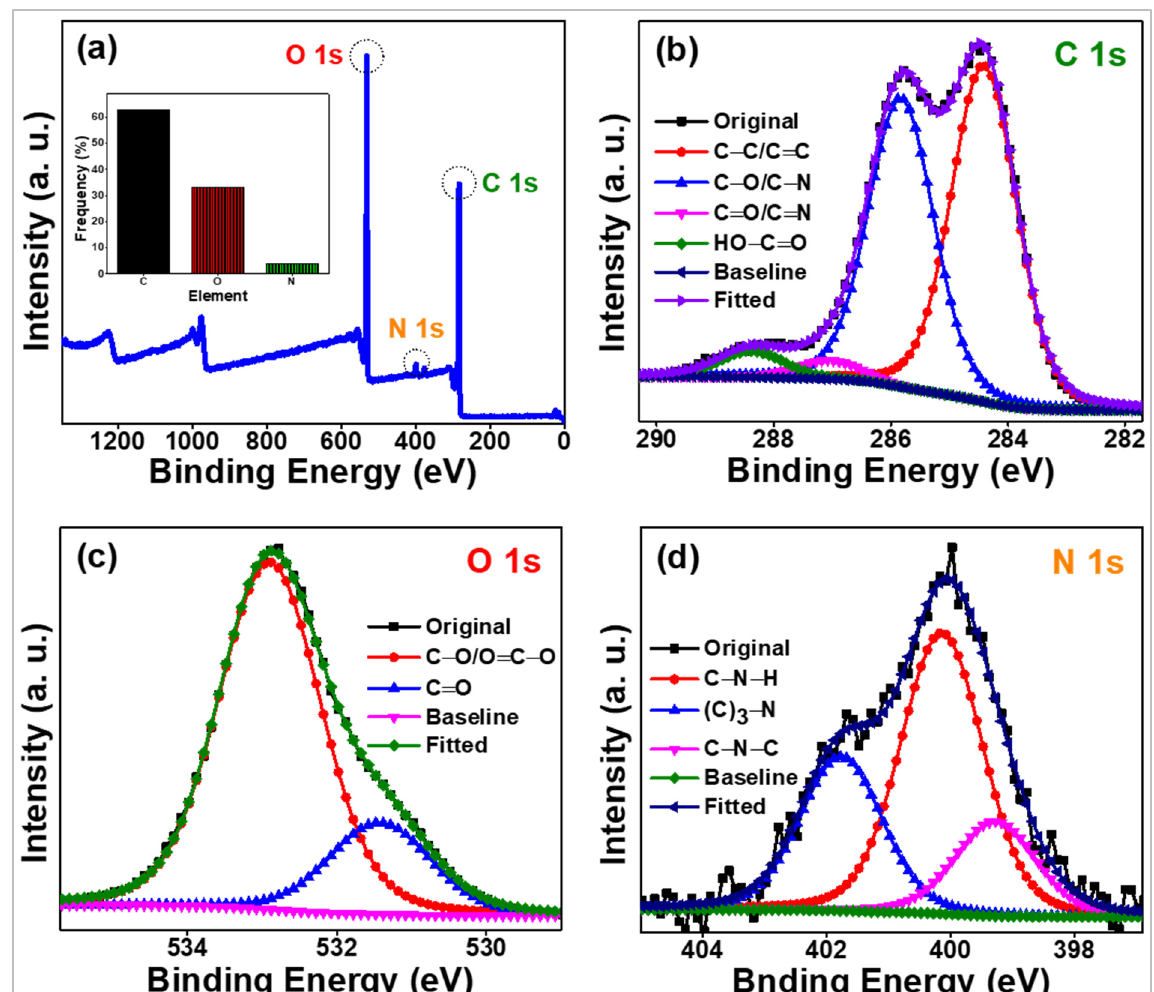
Figure 4. XPS spectra of the prepared natural nitrogen-doped carbon dots: ( a ) survey scan spectrum, ( b ) high-resolution C 1s electron level, ( c ) high-resolution O 1s electron level, and ( d ) high-resolution N 1s electron level. Inset ( a ): bar chart of the atomic percentages of existing elements in the prepared natural nitrogen-doped carbon dots.